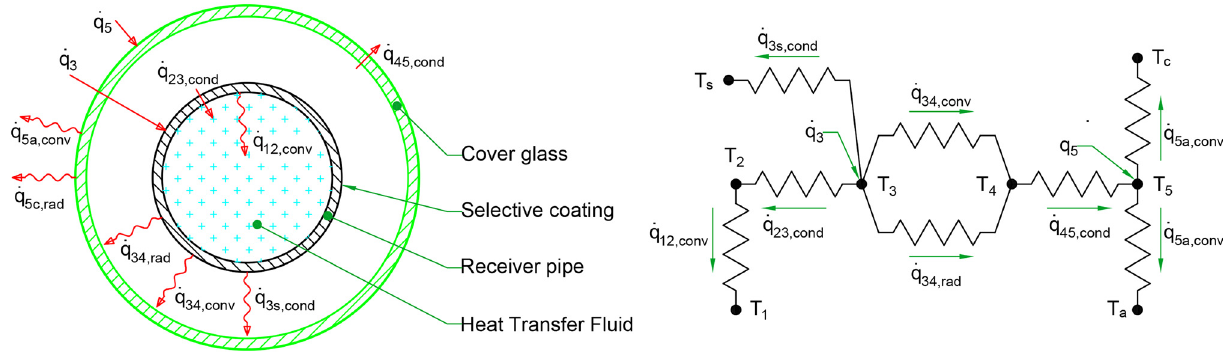
Figure 28: Receiver boundary and thermal resistance model. ( Retrieved from: Brooks MJ. Performance of a parabolic trough solar collector [ Master ’ s thesis ] . Stellenbosch ( ZA ) : University of Stellenbosch; 2005 [ 174 ] .